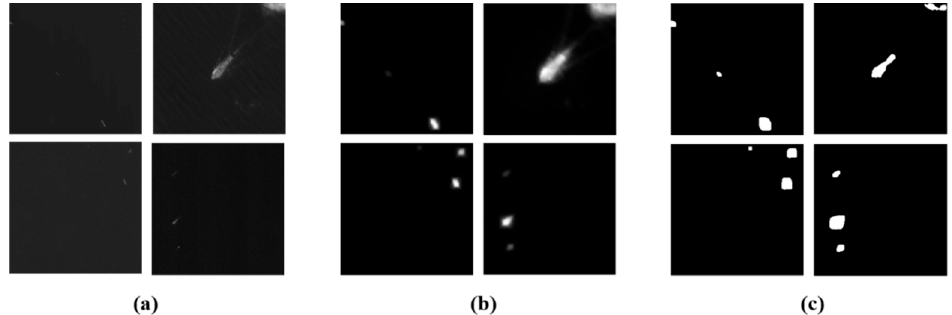
Figure 7. RSM ship detection performance. ( a ) Original simple local scenes; ( b ) RSM saliency map; and ( c ) ship candidate extraction results.